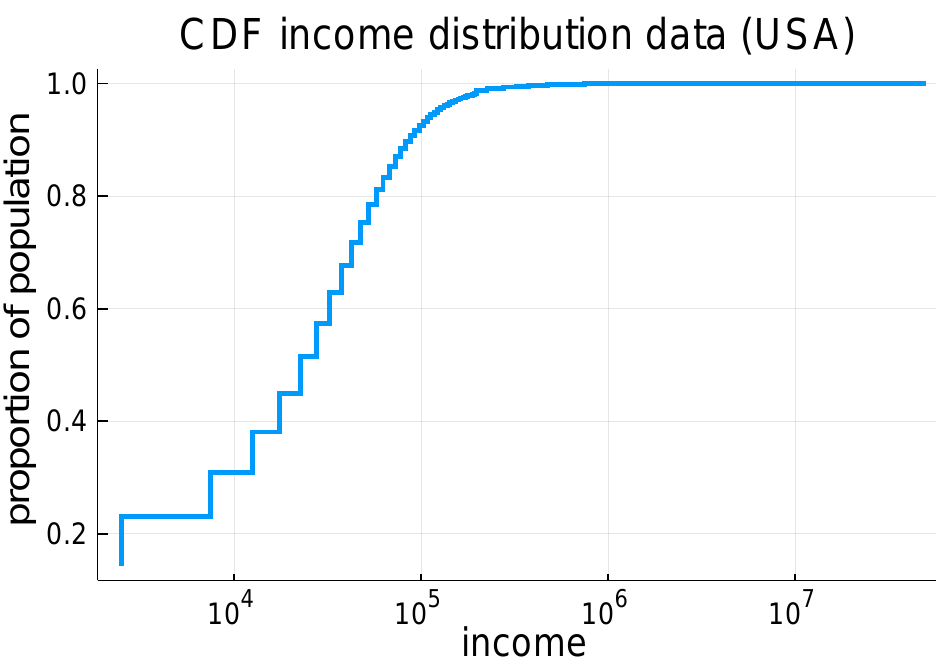
Figure 2. This graph represents the CDF for the incomes in the USA for the year 2014. It is from this distribution that the monetary values for the agents are sampled at the start of the Schelling model